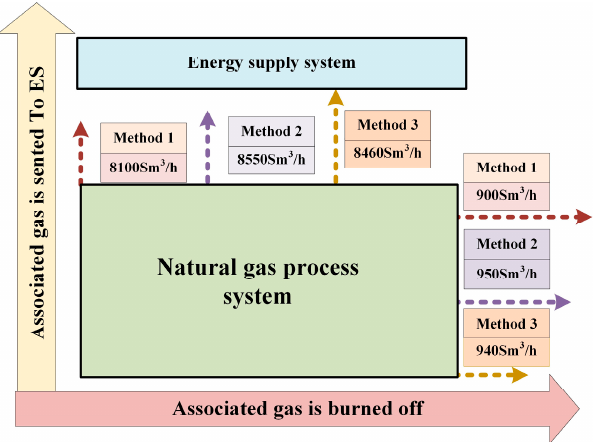
Figure 12. Dispatch of associated gas in the three methods.